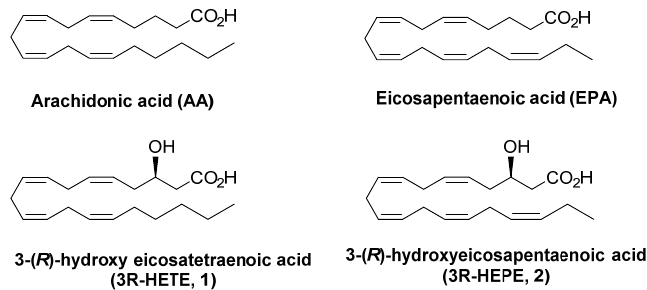
(cid:1) Figure 2. Chemical structures of ( R )-3-hydroxy arachidonic acid ( 1 ) and ( R )-3-hydroxyeicosapentaenoic Figure 2. Chemical structures of ( R ) ‐ 3 ‐ hydroxy arachidonic acid ( 1 ) and ( R ) ‐ 3 ‐ hydroxyeicosapentaenoic acid ( 2 ) with their putative biosynthetic starting materials. acid ( 2 ) with their putative biosynthetic starting